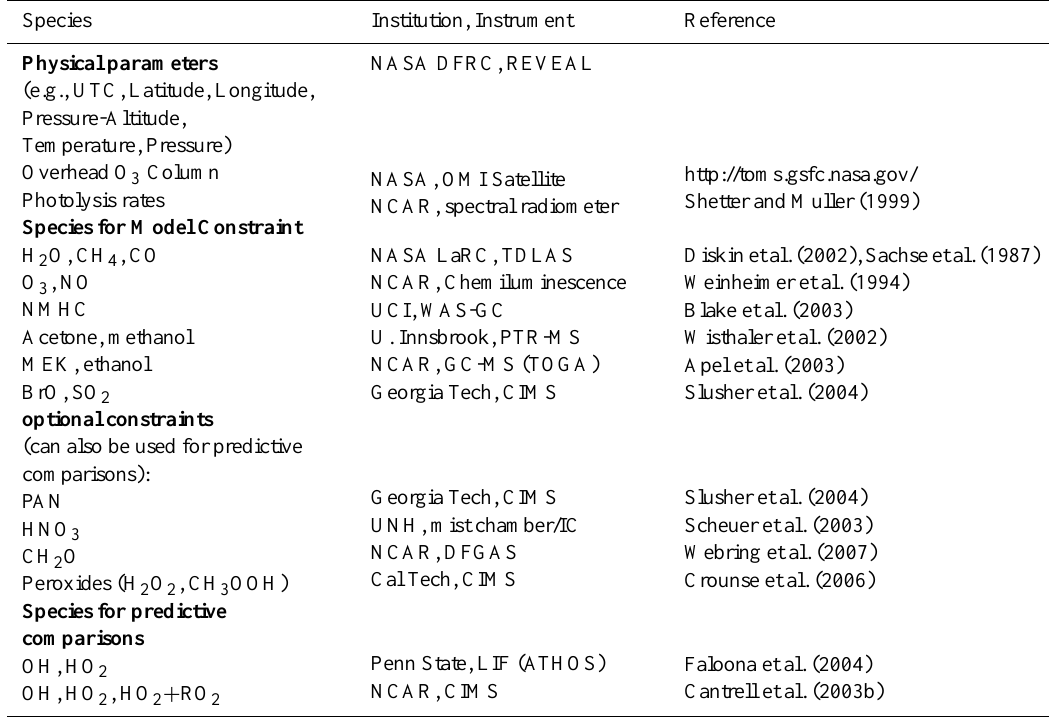
Table 2. Observations used for Model Constraints and/or Predictive